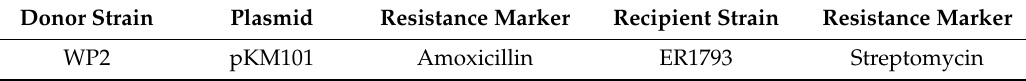
Table 2. The donor and recipient strains used in the conjugation